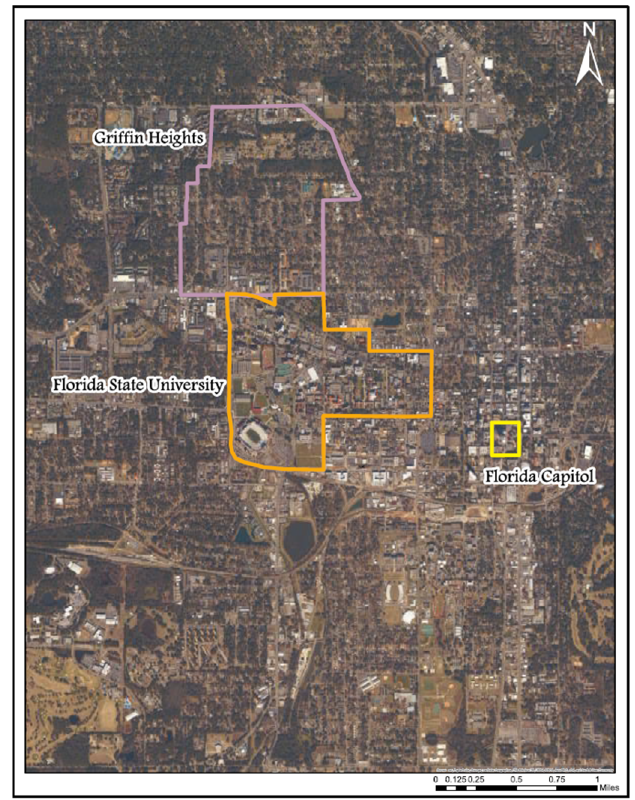
Figure 1. Griffin Heights Location in Relation to FSU and Florida Capital (Source: City of Tallahassee).